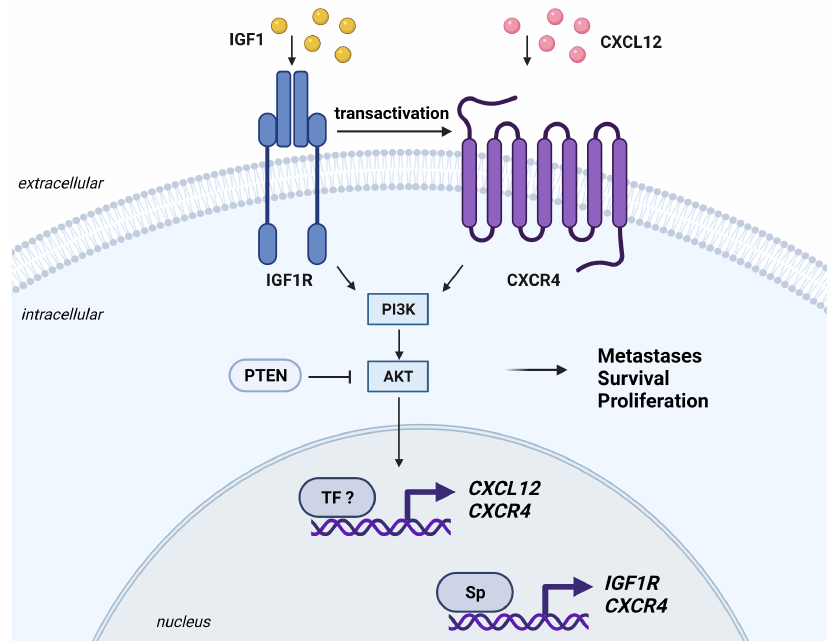
Figure 4. Schematic representation of the functional connection between the IGF system and the CXCR4 signaling in cancer. At the cell membrane, the IGF1/IGF1R axis evokes CXCR4 transactivation, independently of its cognate ligand CXCL12. In the cytoplasm, both IGF1R and CXCR4 stimulate Akt phosphorylation, which is inhibited by PTEN. In the nucleus, Akt transmits signals that favor CXCR4 and CXCL12 mRNA expression, but the exact mechanism is still poorly understood. Sp transcription factors sustain mRNA expression of both the IGF1R and CXCR4 . Biological responses evoked by the IGF/CXCR4 pathways in cancer are